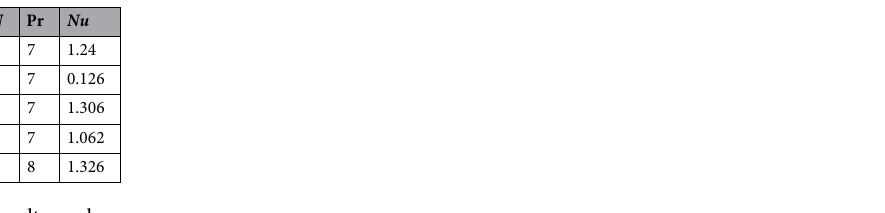
Table 2. Nusselt